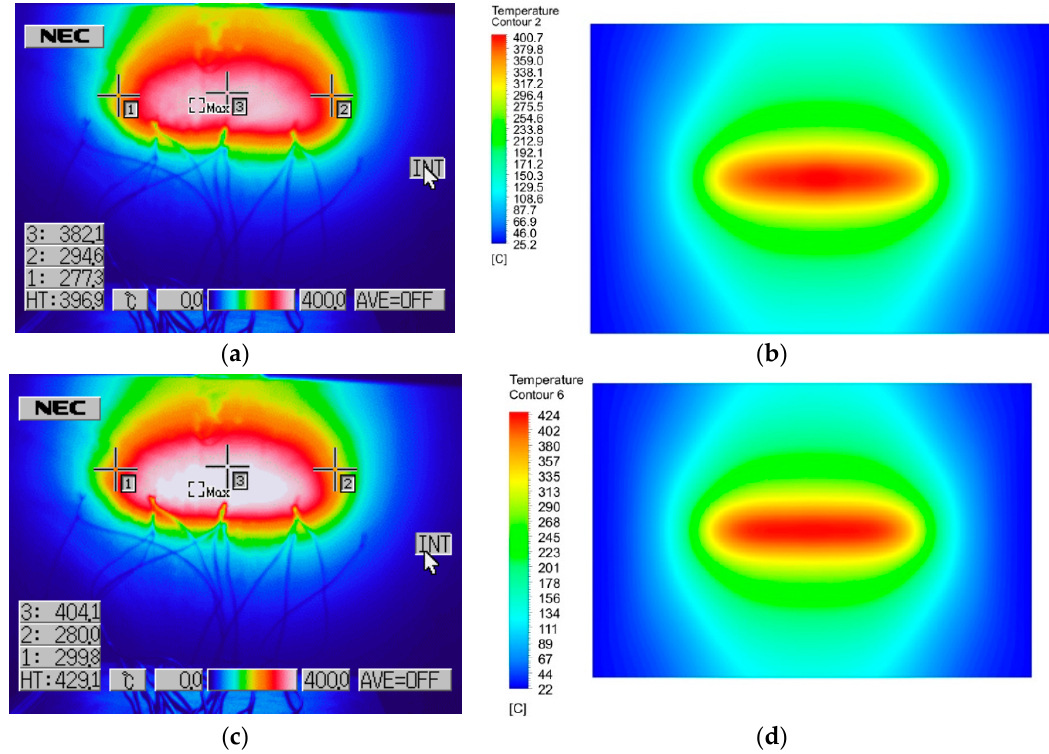
Figure 16. Steel-plate temperature distribution at the back side with complete combustion ( Φ = 1.0): ( a ) basic model experiment; ( b ) basic model simulation; ( c ) modified model experiment; ( d ) modified model simulation.